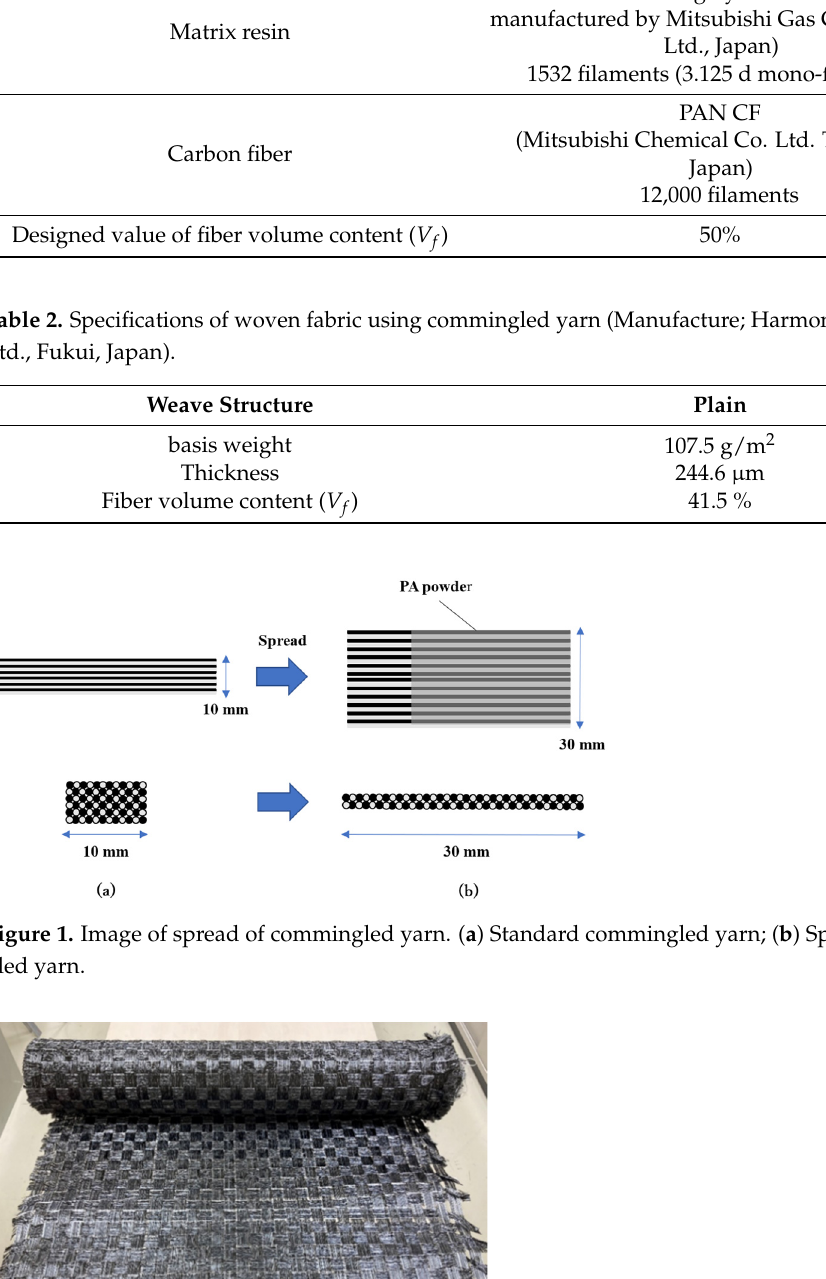
Table 1. Specifications of commingled yarn (Manufacturer; Kajirene Co. Ltd., Kanazawa, Japan).